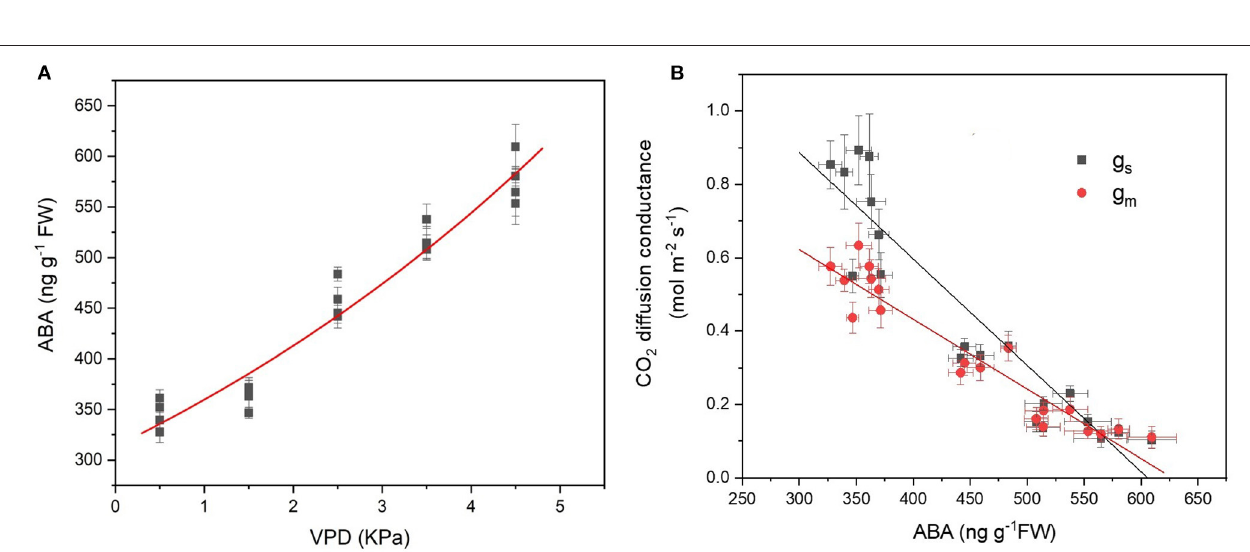
Frontiers in Plant Science |